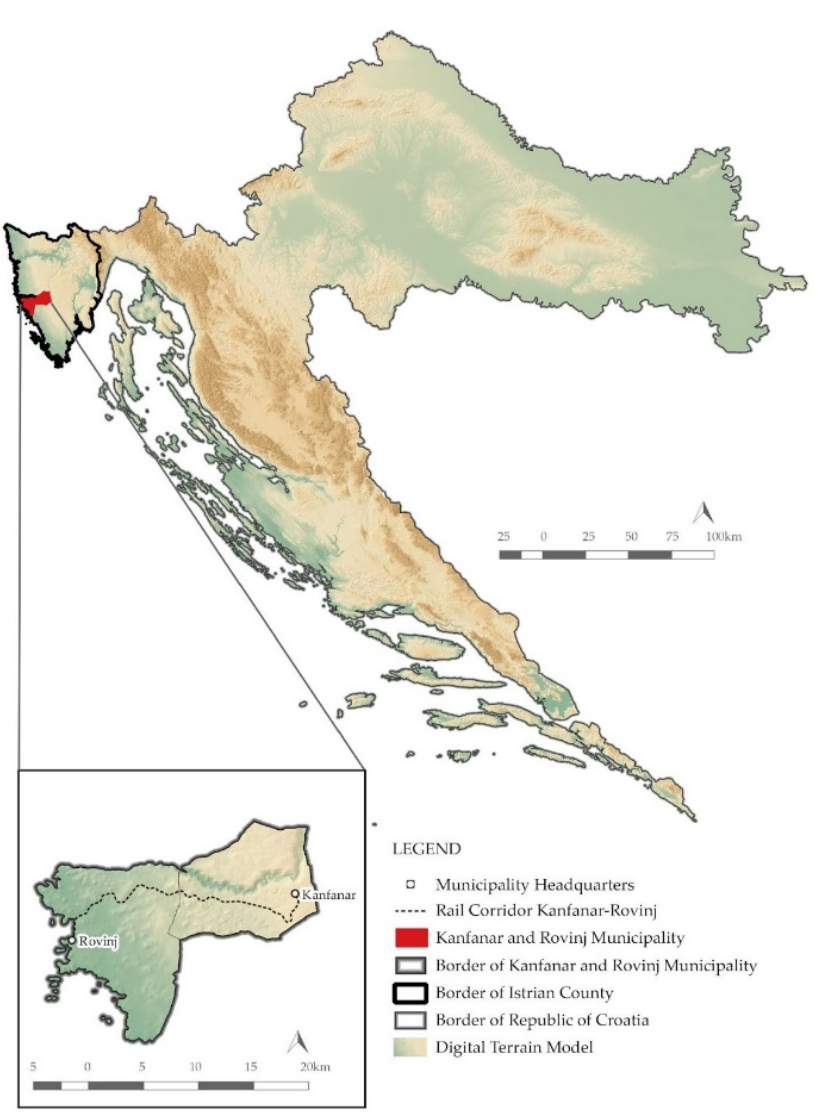
Figure 1. Location of the railway in the regional and national context.